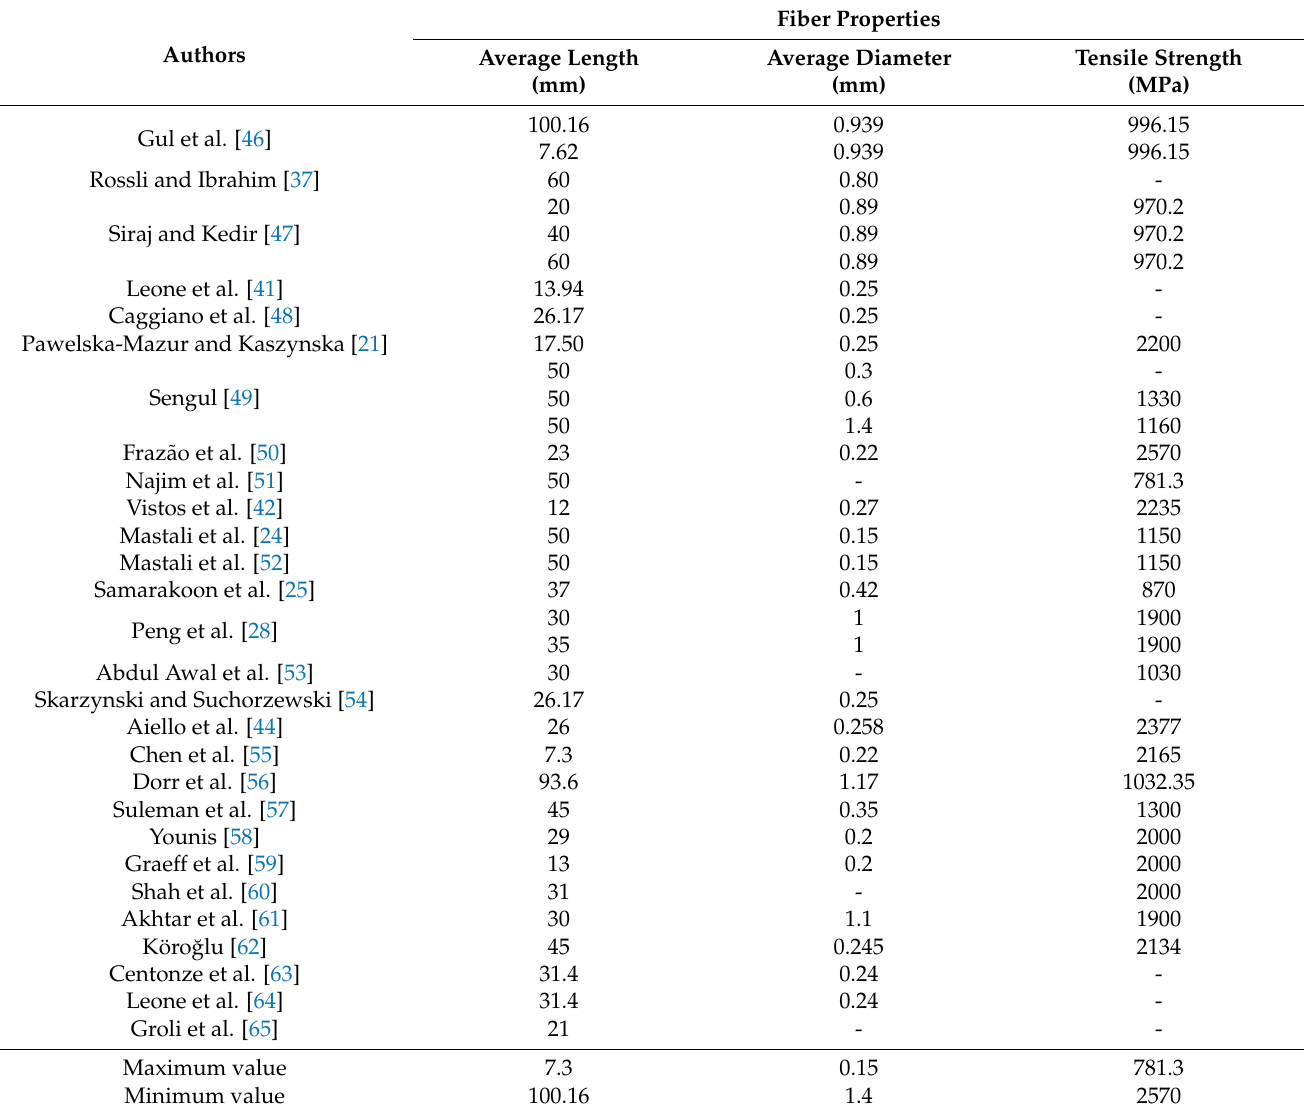
Table 1. Characteristics of the raw steel fibers recovered from waste tires used in cement